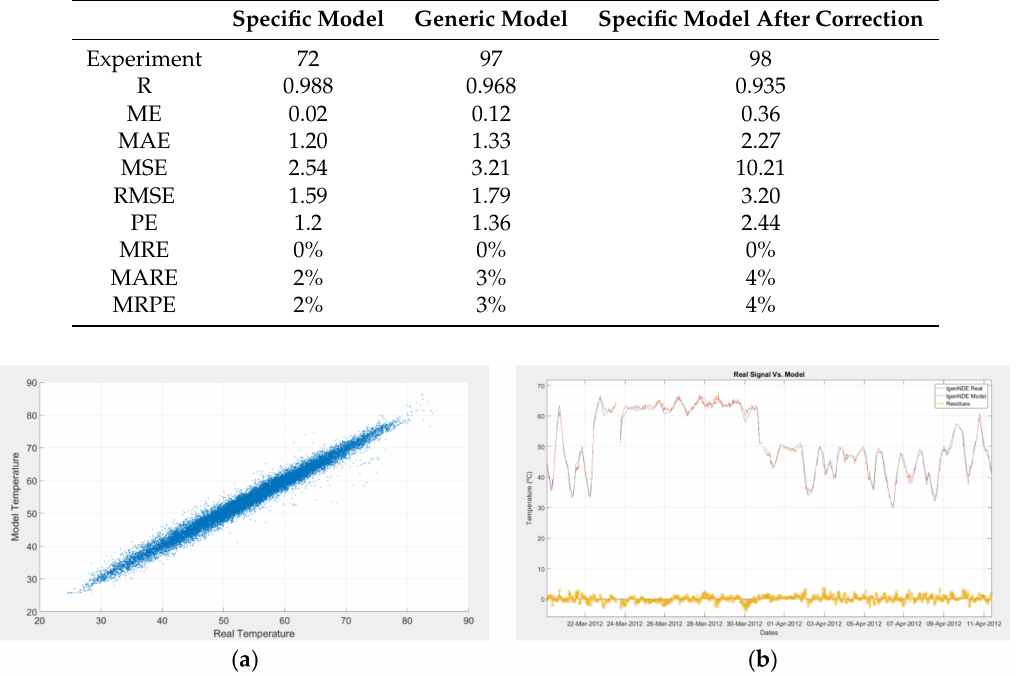
Figure 7. Specific Model: ( a ) Regression line; and ( b ) real temperature (in blue) and estimated temperature (in red) of the NDE bearing, and residues of the model (in